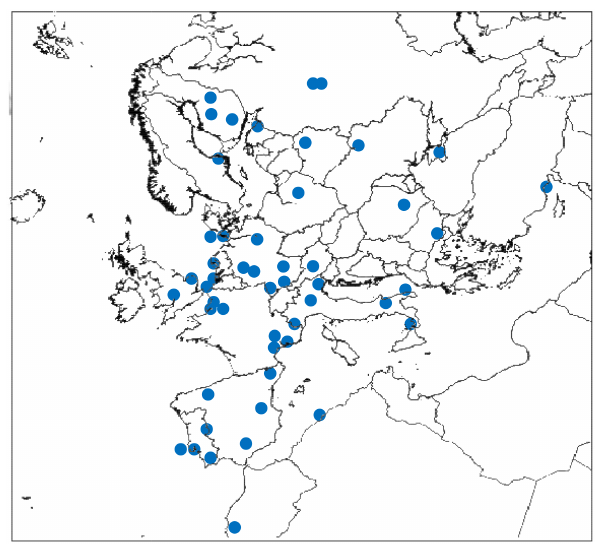
Figure 1. Geographical distribution of the 50 AERONET stations used in the present study.